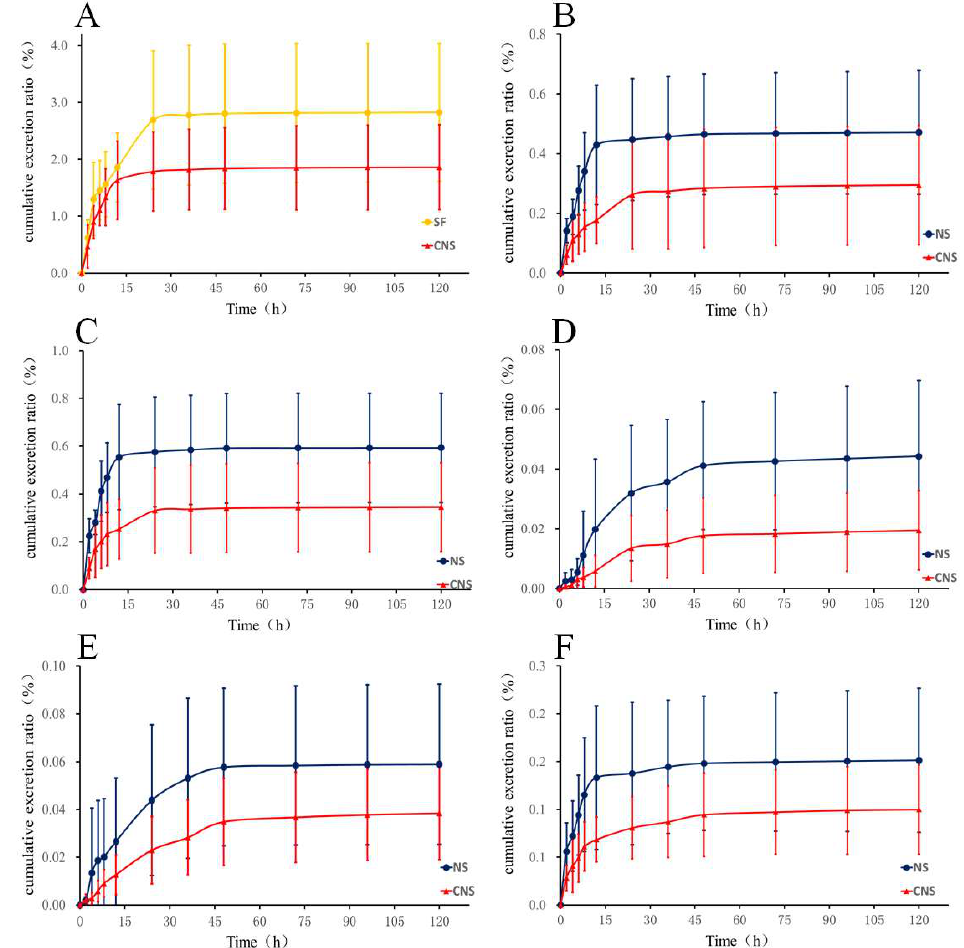
Figure 1. Urinary cumulative excretion profile of ( A ) HSYA in rats after oral administration of SF and CNS and ( B ) Ginsenoside Rg1, ( C ) Ginsenoside R1, ( D ) Ginsenoside Rd, ( E ) Ginsenoside Rb1, and ( F ) Ginsenoside Re in rats after oral administration of NS and CNS ( n =